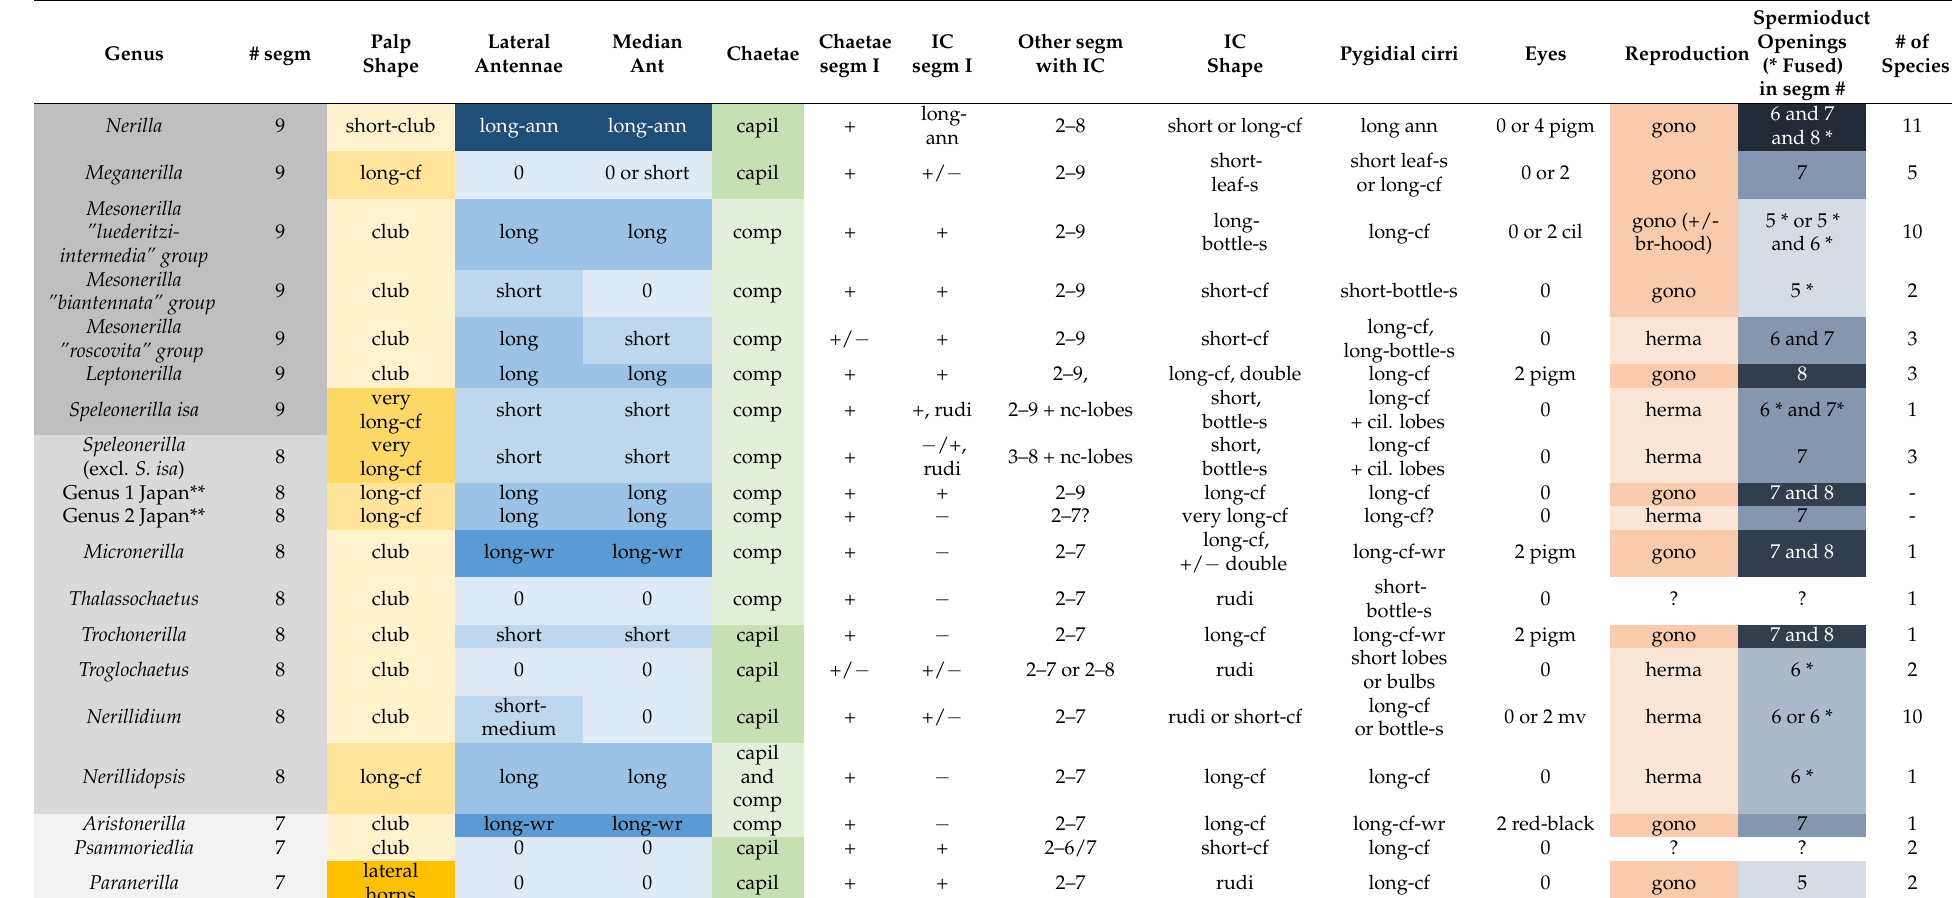
Table 2. Diagnostic characters of the nerillid genera (and major clades within). Cell shading to distinguish differences. Ann, annulated; ant, antenna; br, brooding; capil, capillary; cf, cirriform; cil, ciliary; club, club-shaped; comp, compound; gono, gonochoristic; herma, hermaphroditic; IC, interramal cirri; mv, microvillar; nc, neurochaetal; pigm, pigmented; rudi, rudimental; s, shaped; segm, segment; wr, wrinkled; **, unpublished data, #, number. Palp Genus # segm